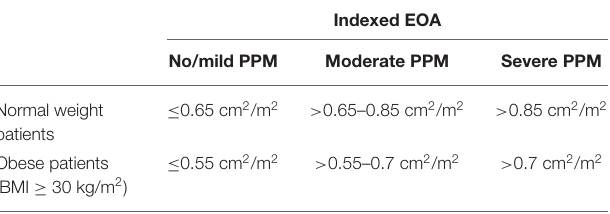
TABLE 1 | Thresholds for prosthesis-patient mismatch